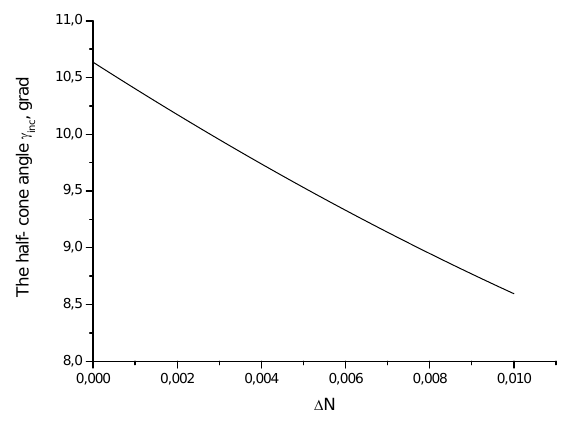
Figure 2: The dependence on the deviation of inclusion factor N Δ of the half-cone angle of incident Bessel light beam for which Bessel plasmon polariton is excited in ENZM slab made of alumina oxide with periodically embedded silver nanocylinders ( 25 = r nm) and surrounded by air. Here 633 =λ